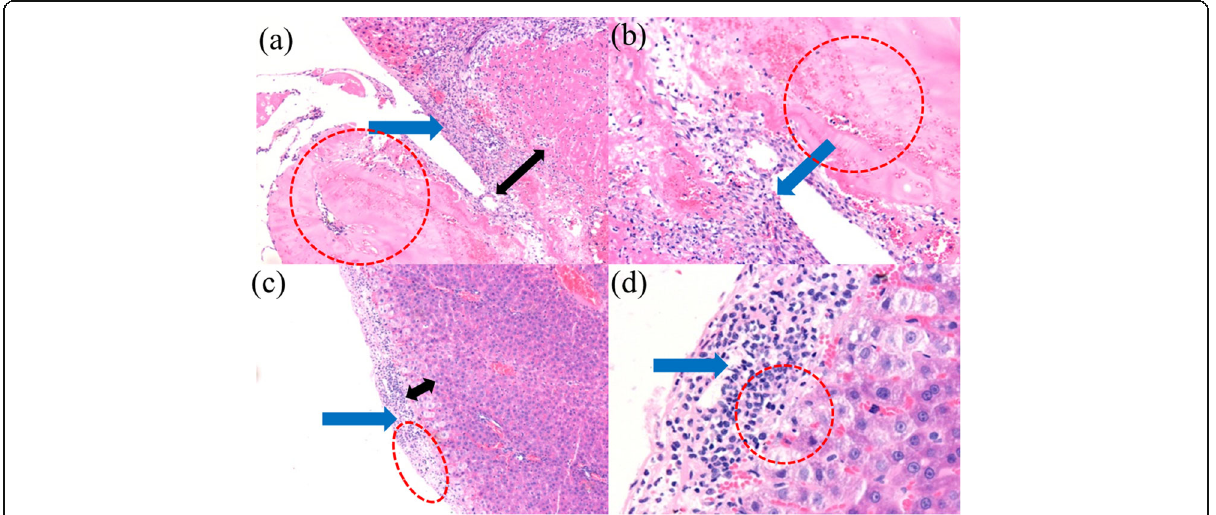
Fig. 6 Histopathological examination with HE staining observed under a , c magnification × 100 and b , d magnification × 200. Histopathological examination shows an inflammatory response and liver injury among hepatocytes in two groups at the seventh day. The two groups are the a , b airflow-assisted group and c , d electric field-modified group (blue arrow: inflammatory cells; red circle: medical glue; black arrow: thickness of hyperemia